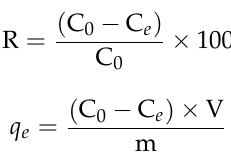
Table 1. Chemical structure and normalized cost of different